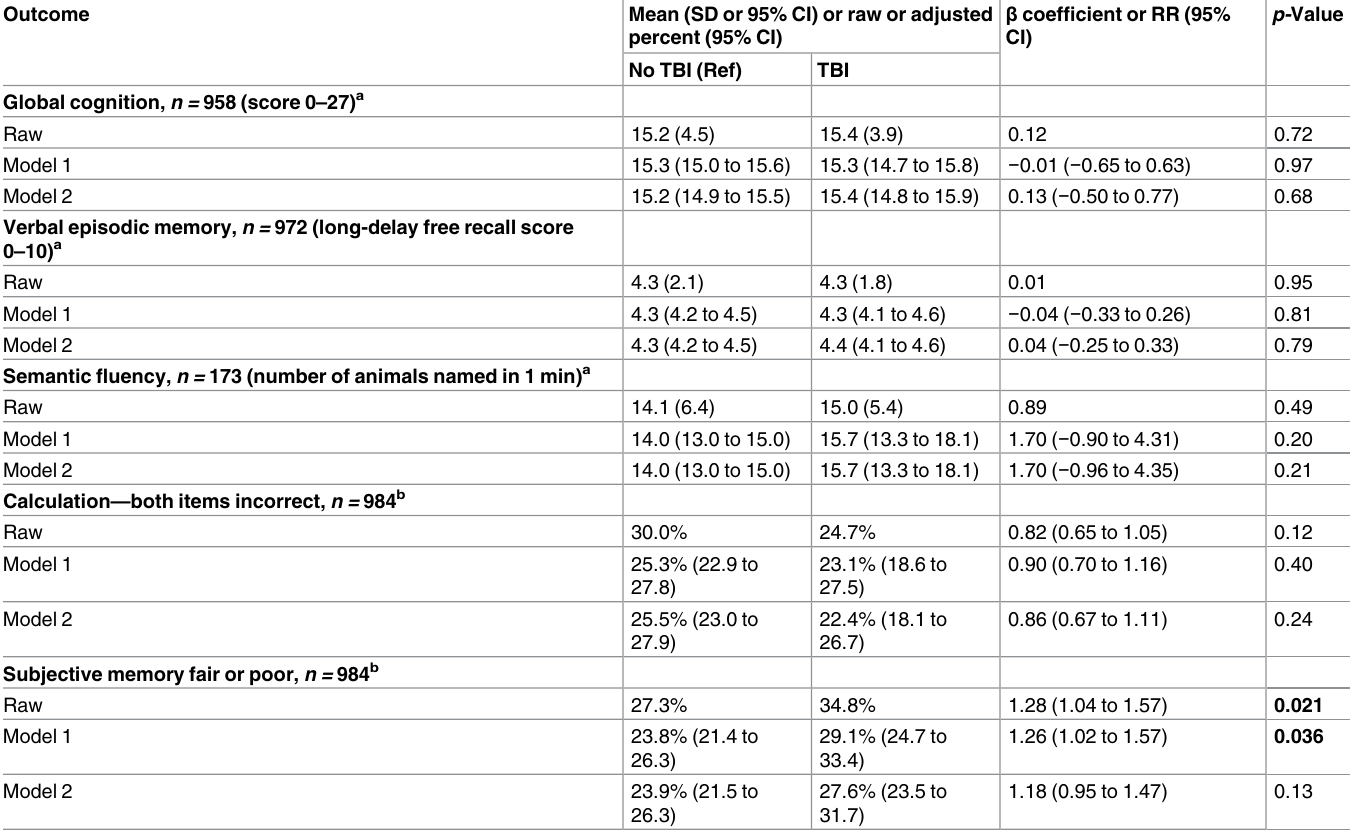
Statistically significant results are in bold. Model 1: adjusted for age, sex, heart disease, lung disease, and arthritis. Model 2: adjusted for age, sex, heart disease, lung disease, arthritis, and depression. a Values are mean (SD) or adjusted mean (95% CI); β coefficient (95% CI). b Values are raw or adjusted percent (95% CI); RR (95%